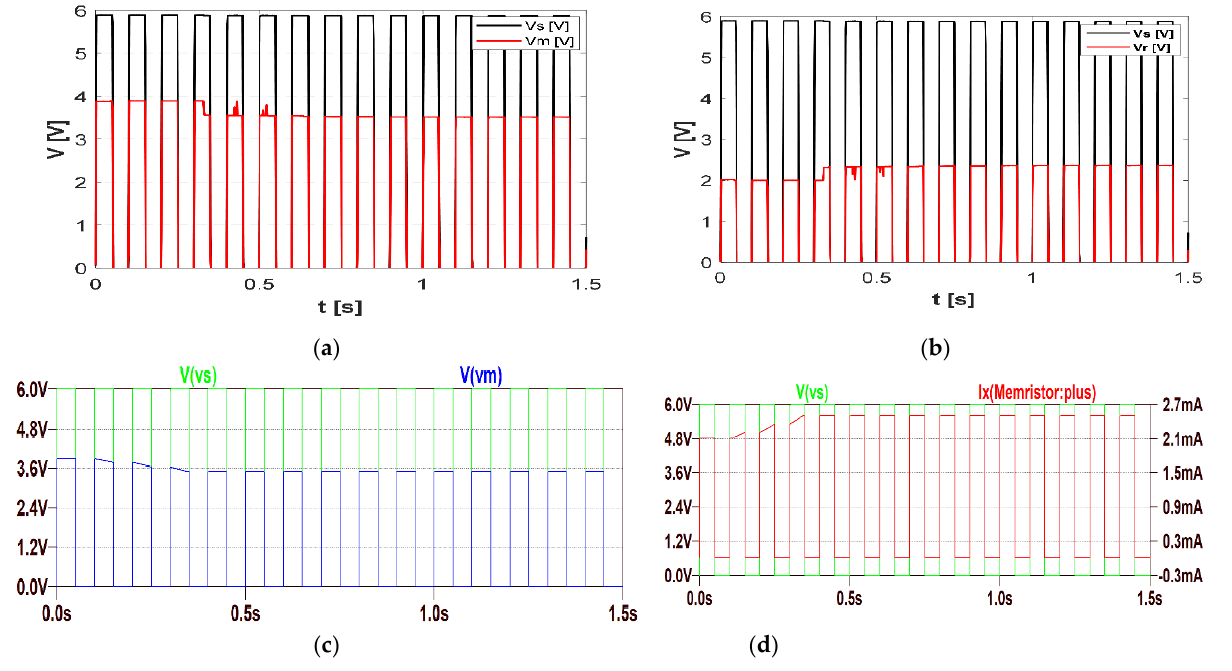
Figure 8. Experimental ( a , b ) and simulated response of LIF neuron circuit with volatile memristor under multiple pulses voltage actuation. ( a ) Voltage across memristor-experimental analysis; ( b ) voltage across constant resistor-experimental analysis; ( c ) voltage across memristor–simulation analysis; ( d ) memristor current–simulation analysis.